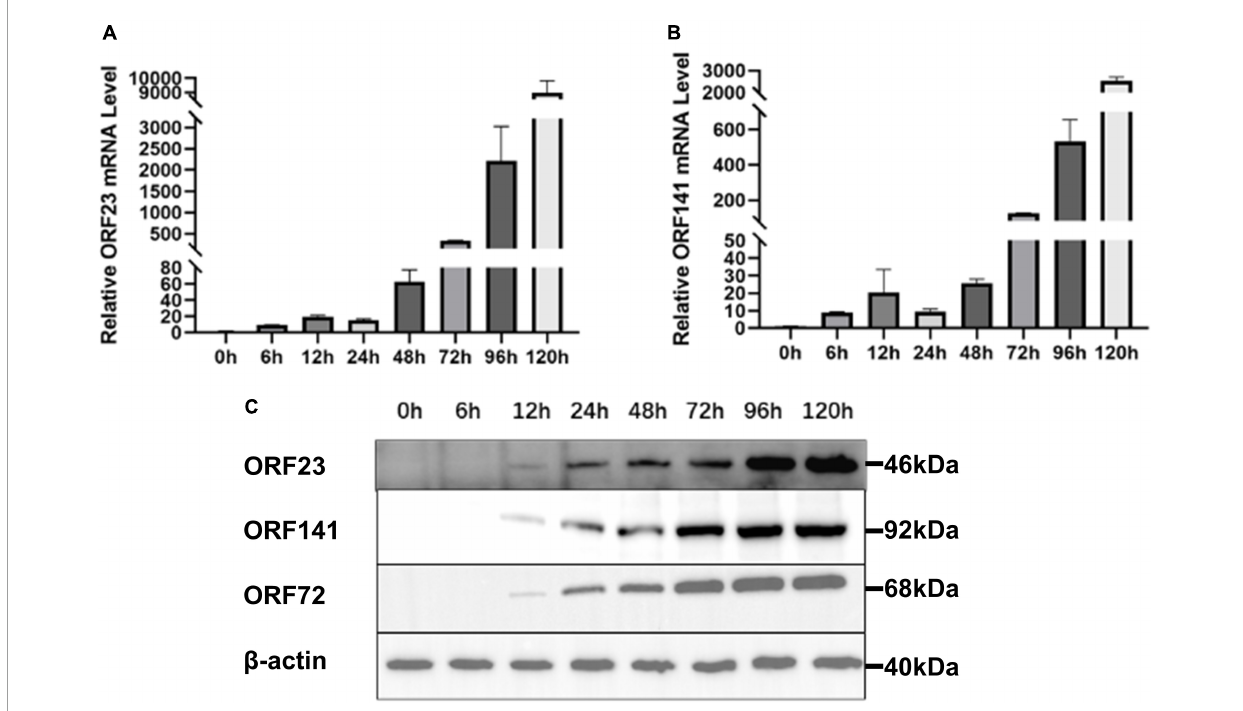
FIGURE3 Expression mRNA and translation levels of ORF23 and ORF141 in GICF during CyHV-2 infection. (A) Total RNA of GICF cells infected by CyHV-2 (MOI = 1) was extracted at 0, 6, 12, 24, 48, 72, 96, and 120 hpi, the relative expression of ORF23 was detected by RT-qPCR with β -actin as internal control. (B) Total RNA of GICF cells infected by CyHV-2 (MOI = 1) was extracted at 0, 6, 12, 24, 48, 72, 96, and 120 hpi, the relative expression of ORF141 was detected by RT-qPCR with β -actin as internal control. (C) ORF23, ORF141, and ORF72 protein expression was positively correlated. The total protein of GICF cells infected CyHV-2 (MOI = 1) was collected at 0, 6, 12, 24, 48, 72, 96, and 120 hpi and detected by Western